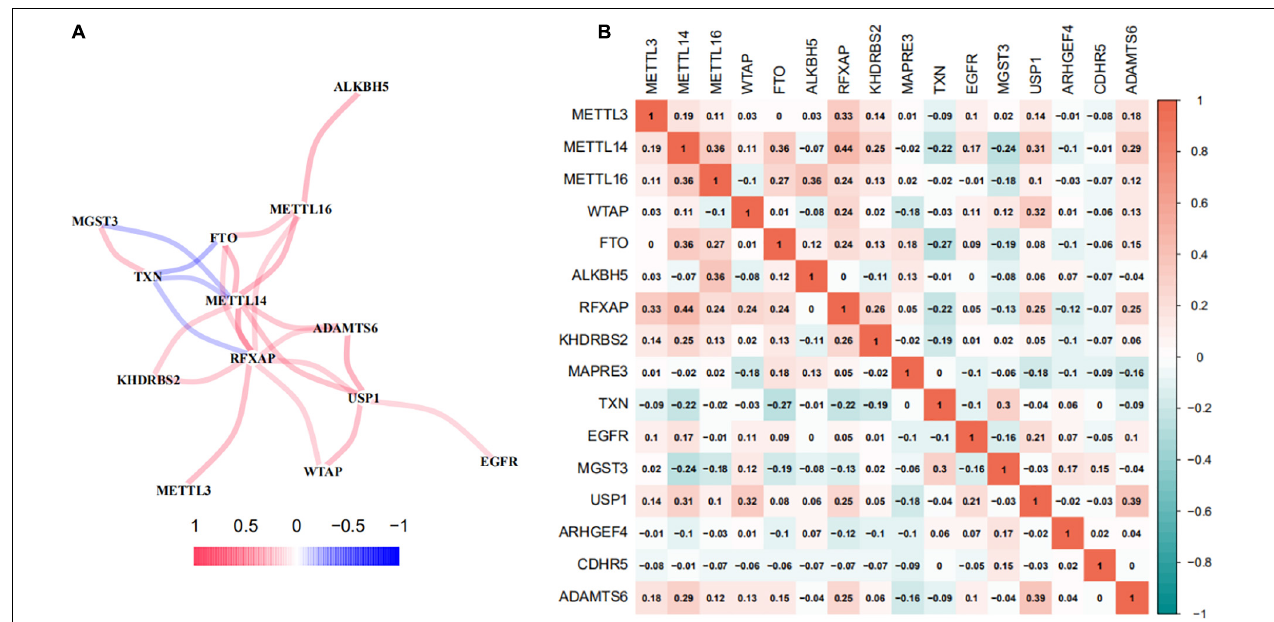
FIGURE 8 | Co-expression and interaction network analyses between m6A regulators and m6A-RPS. (A) Spearman correlation analysis and (B) co-expression network of m6A RNA methylation regulators, methyltransferases (METTL3, METTL14, METTL16, and WTAP), demethylases (FTO and ALKBH5) and 10 m6A-regulated mRNAs in the prognostic signature in TCGA LUAD patient